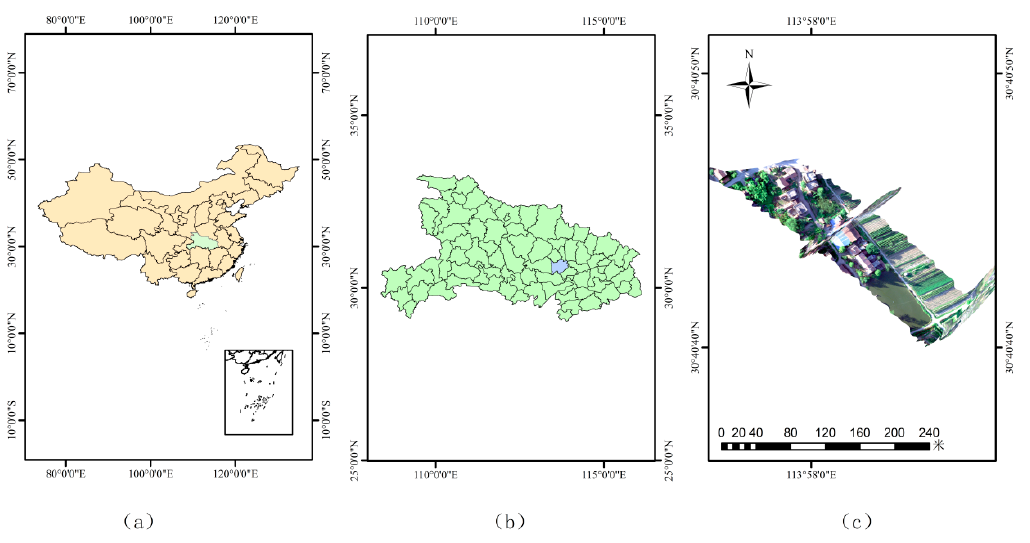
Figure 3. ( a ) The location of Hubei Province in China. ( b ) Administrative area map of the city of Hanchuan in Hubei Province. ( c ) The study site.